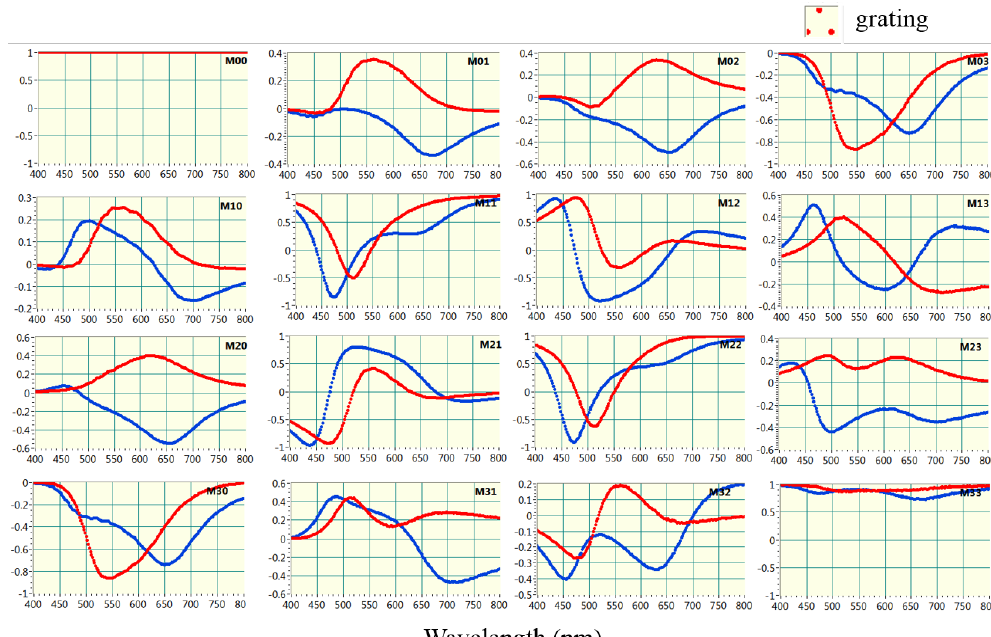
Figure 7. Spectroscopic Mueller matrices measured for the leakage wave of the lens and the grating. All of the Mueller matrix elements have been normalized to the element m 00 .